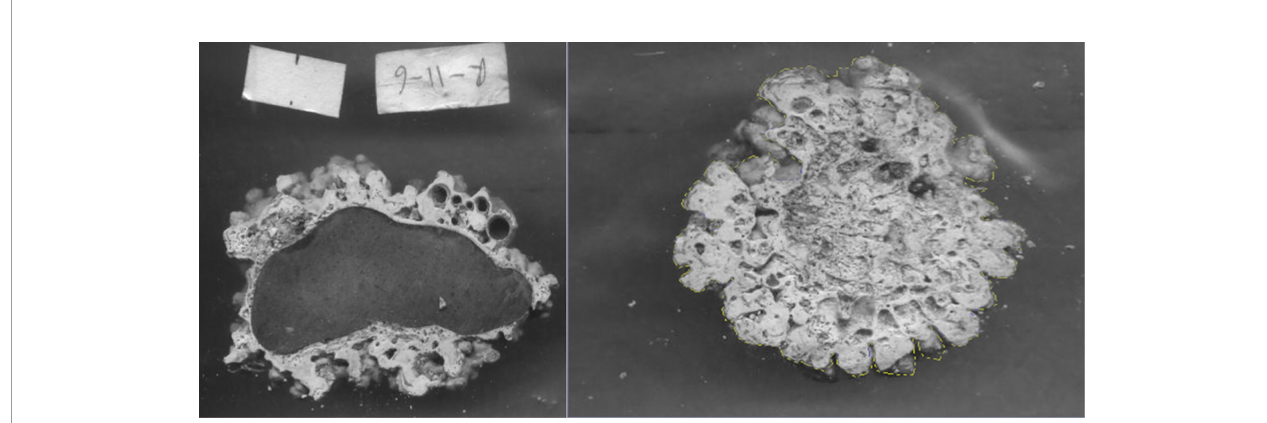
FIGURE 2 | Scanned halves of sawed rhodolith from Isla del Coco to determine